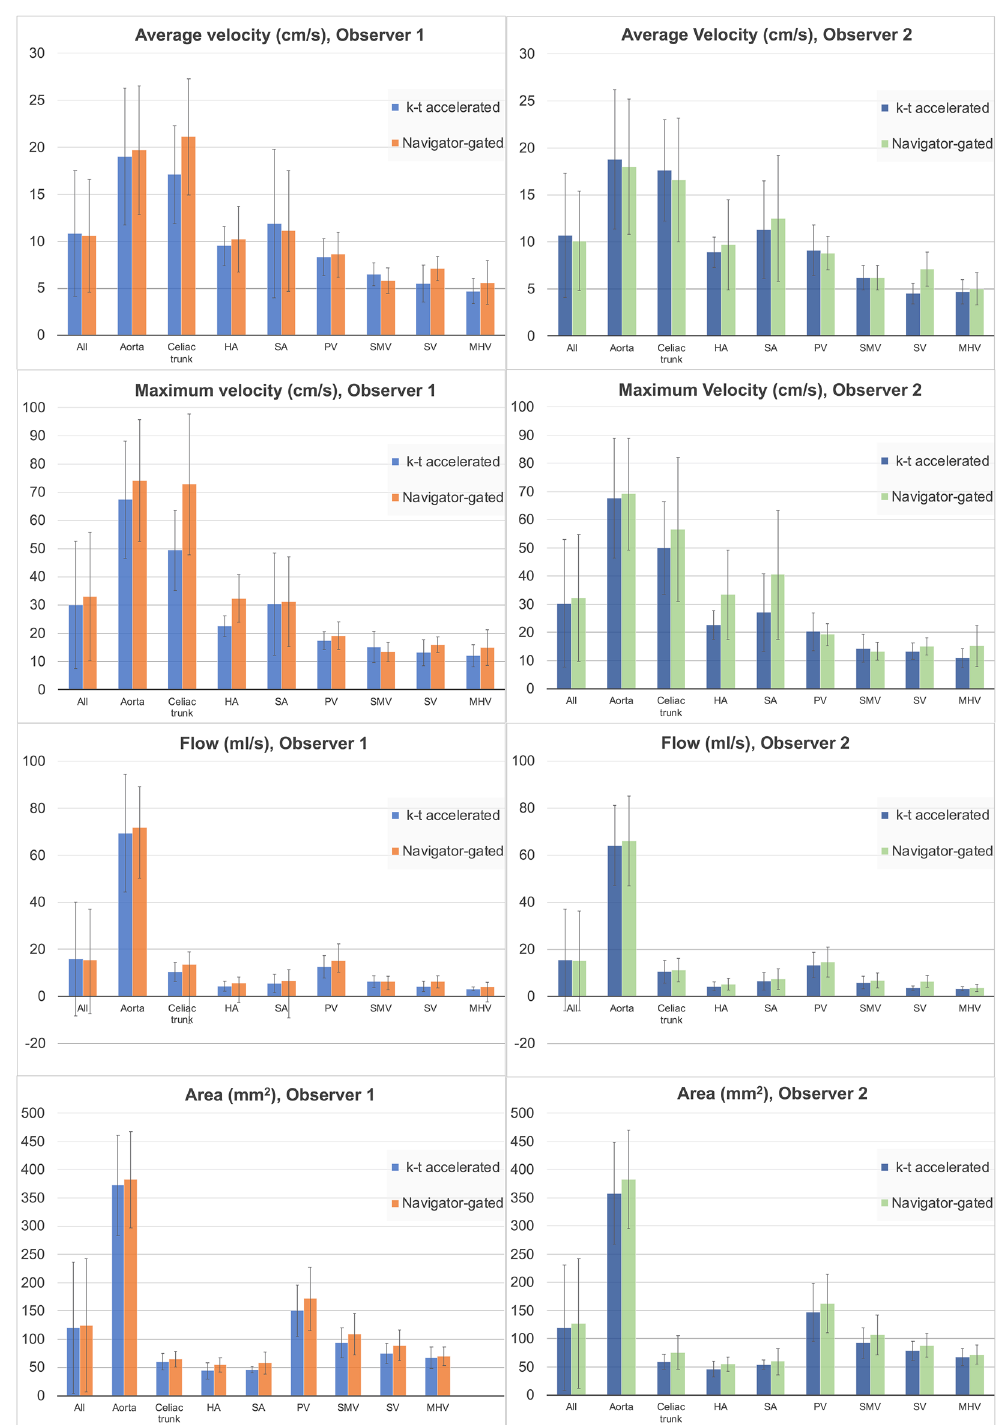
Figure 2. Hemodynamic parameters measured by both observers with both acquisitions, in all vessels. Bar graphs show mean ± standard deviation. HA hepatic artery, MHV middle hepatic vein, PV portal vein, SA splenic artery, SMV superior mesenteric vein, SV splenic